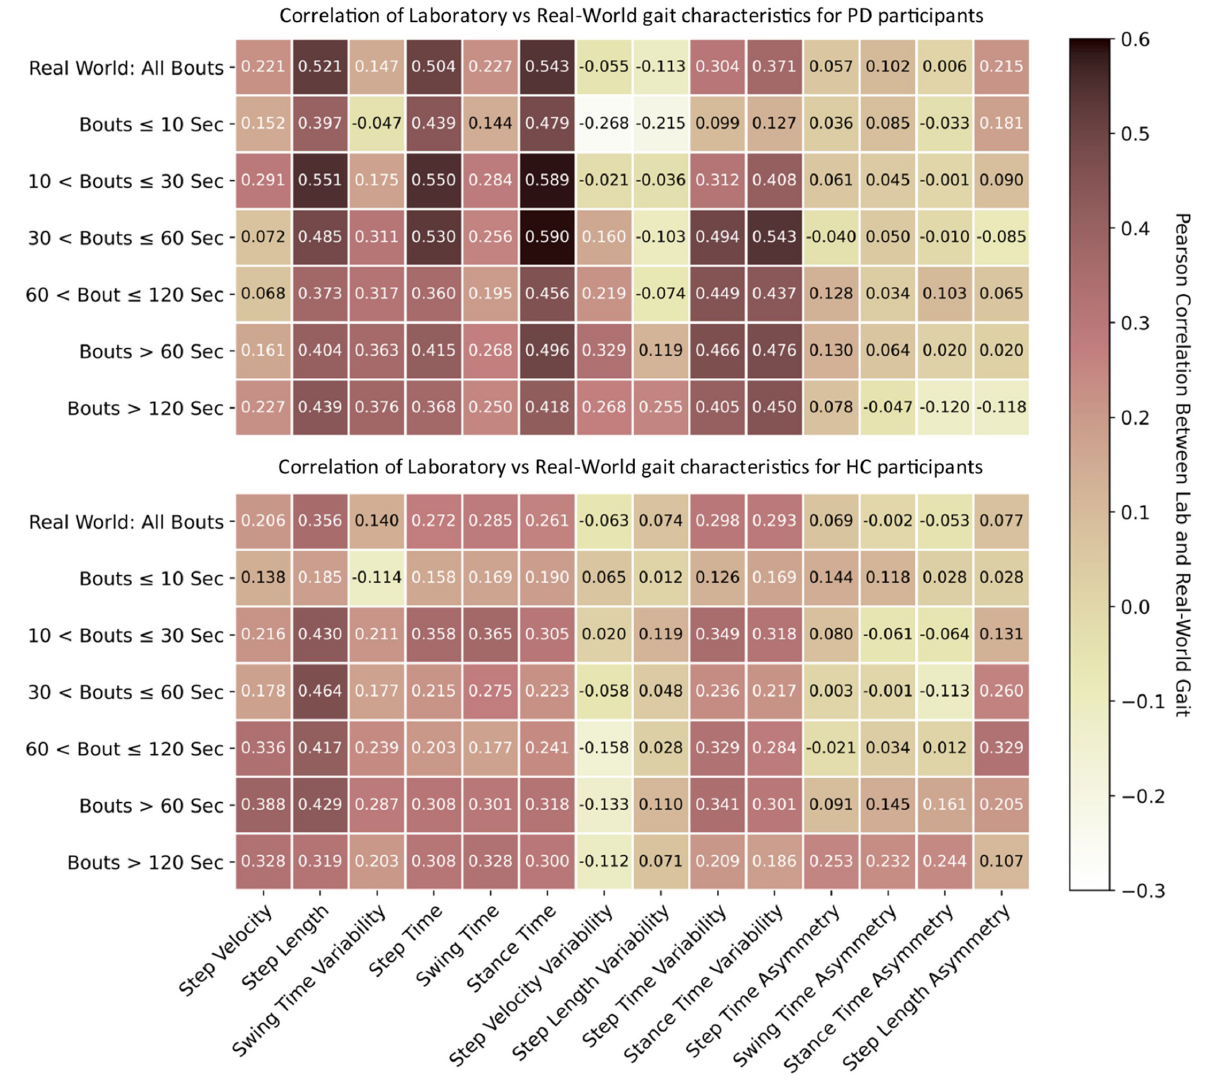
gait assessed for 7 consecutive days across all gait domains (pace, rhythm, variability, asymmetry, and postural